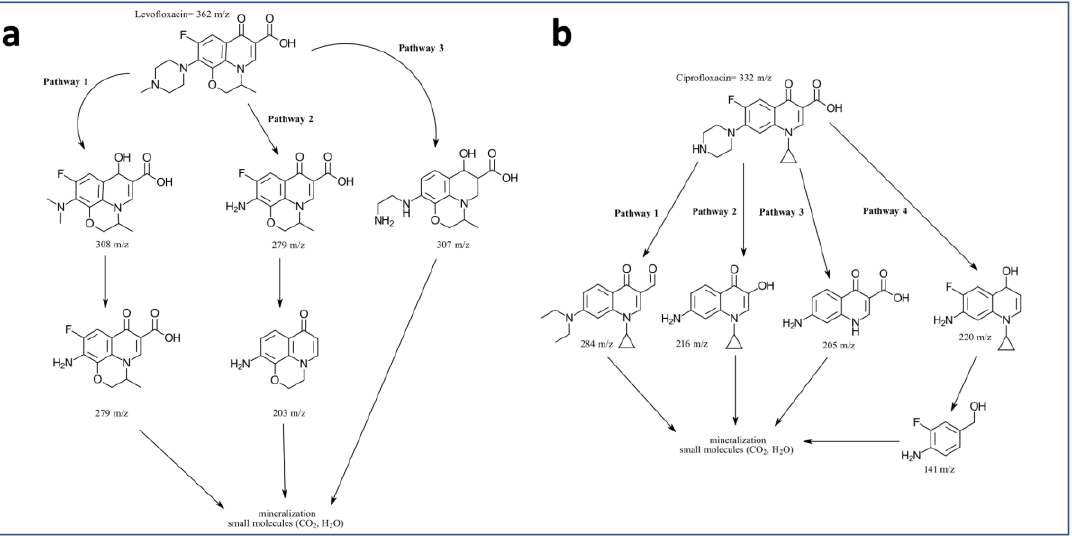
Figure 8. Degradation pathway of LFX ( a ) and CFX ( b ) under the effects of the most active catalysts (5%Au@ZnONPs-3%MoS 2 -1%rGO and 1%Au@ZnONPs-3%MoS 2 -1% rGO, respectively).